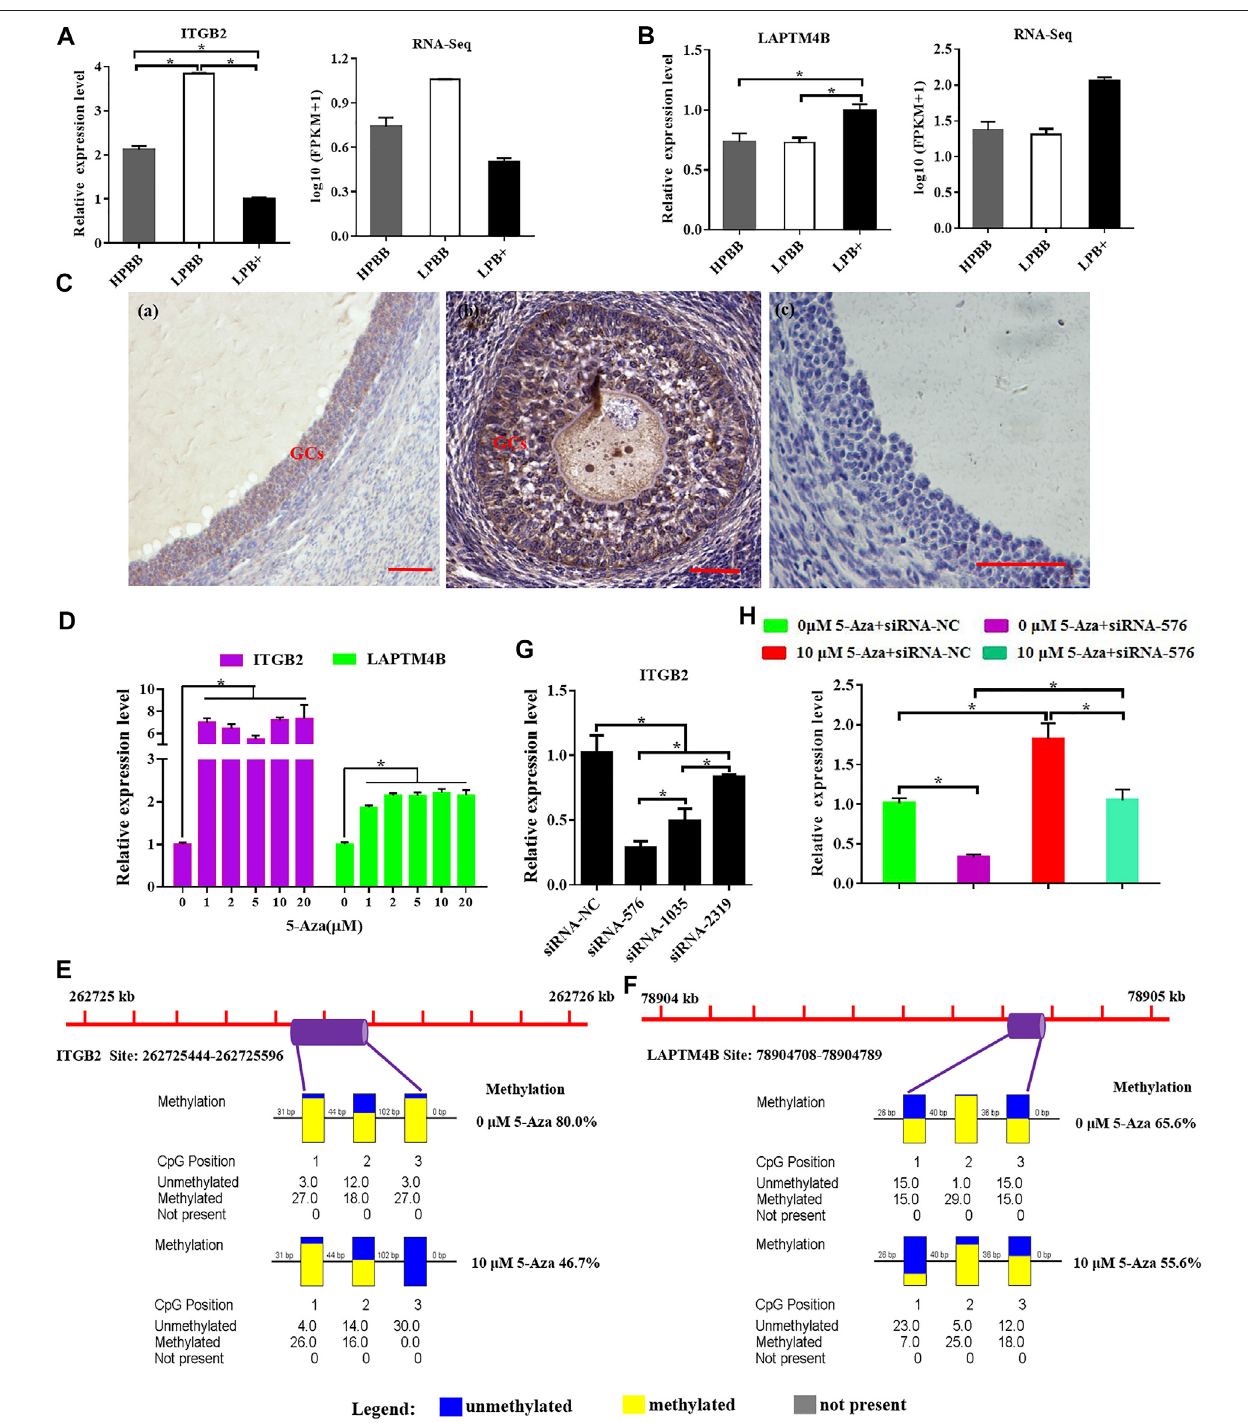
FIGURE 8 | Integrative analysis of methylation and expression levels of ITGB2 and LAPTM4B. (A,B) ITGB2 and LAPTM4B mRNA expression in the ovaries were detectedbyqRT-PCR. (C) LocalizationofLAPTM4Bintheovariesusingimmunohistochemistry.Scalebars=50 μ m. (D) ITGB2andLAPTM4BmRNAexpressionlevels inculturedGCsweredetectedaftertreatmentwithvariousconcentrations(0,1,2,5,10,and20 μ M)of5-Azatreatment. (E,F) MethylationlevelsofITGB2andLAPTM4B inculturedGCsafter10 μ M5-Azatreatment. (G) Suppressionef fi ciencyofITGB2wasevaluatedbyqRT-PCR. (H) mRNAlevelofITGB2inculturedGCsstimulated by 5-Aza with or without